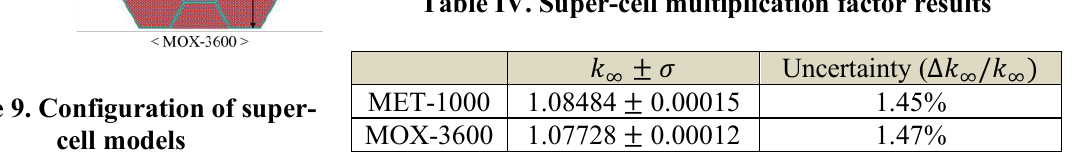
Table IV. Super-cell multiplication factor